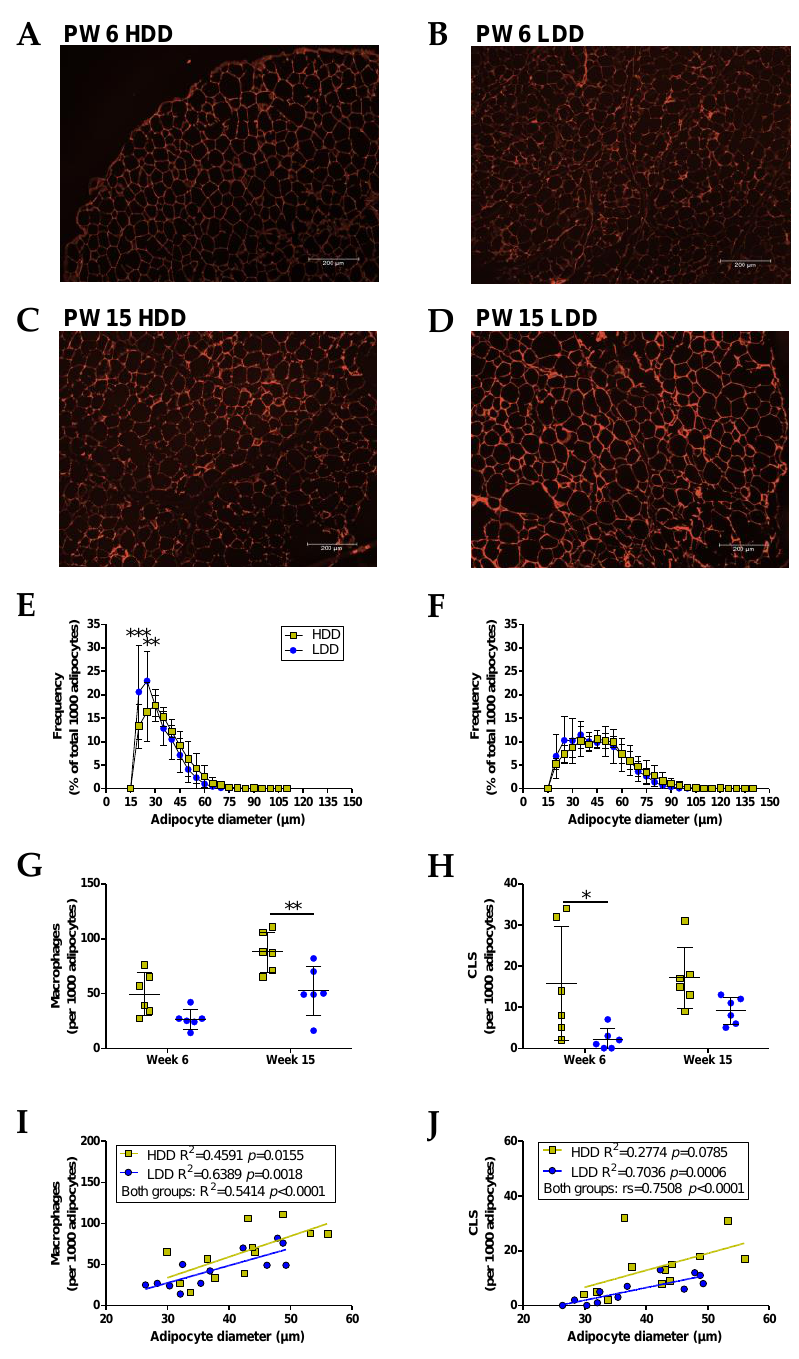
Figure 5. Adipose tissue histology, adipocyte size distribution, and macrophage infiltration markers in the gWAT of females at the end of the post-weaning intervention (PW 6) and after the HFD feeding period (PW 15). Representative histological pictures of gWAT using hematoxylin–eosin (HE) staining in HDD-fed ( A ) and LDD-fed mice ( B ) at the end of the post-weaning intervention (PW 6), and HDD-fed ( C ) and LDD-fed mice ( D ) after the HFD feeding period (PW 15). Photos were made using fluorescent microscopy. Distribution of adipocyte diameter (5 µm bins) in gWAT pads collected in PW 6 ( E ) and PW 15 ( F ). Total count of macrophages ( G ) and crown-like structures (CLS, H ) identified in the same areas using MAC-2 immunohistochemical staining. Correlation plots of adipocyte diameters with ( I ) macrophage and ( J ) CLS counts for all of the animals in each group. All of the coefficients were obtained with Pearson correlation except for the CLS of the combined HDD and LDD groups (rs = Spearman correlation coefficient). n = 12 per dietary group, n = six per age (PW 6 or PW 15). Data shown as mean ± s.d. Statistical differences denoted as ** p ≤ 0.01 and *** p ≤ 0.001.